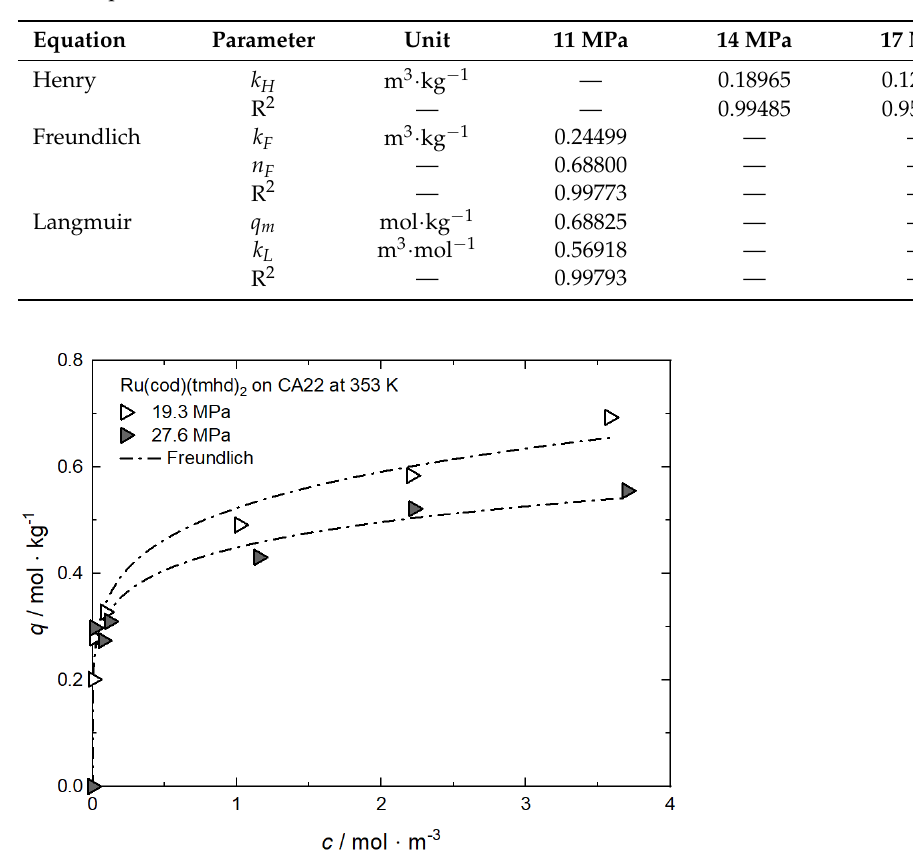
Figure A3. Uptake of Ru(cod)(tmhd) 2 on CA22 at 353 K and different pressures; experimental data taken from [63].